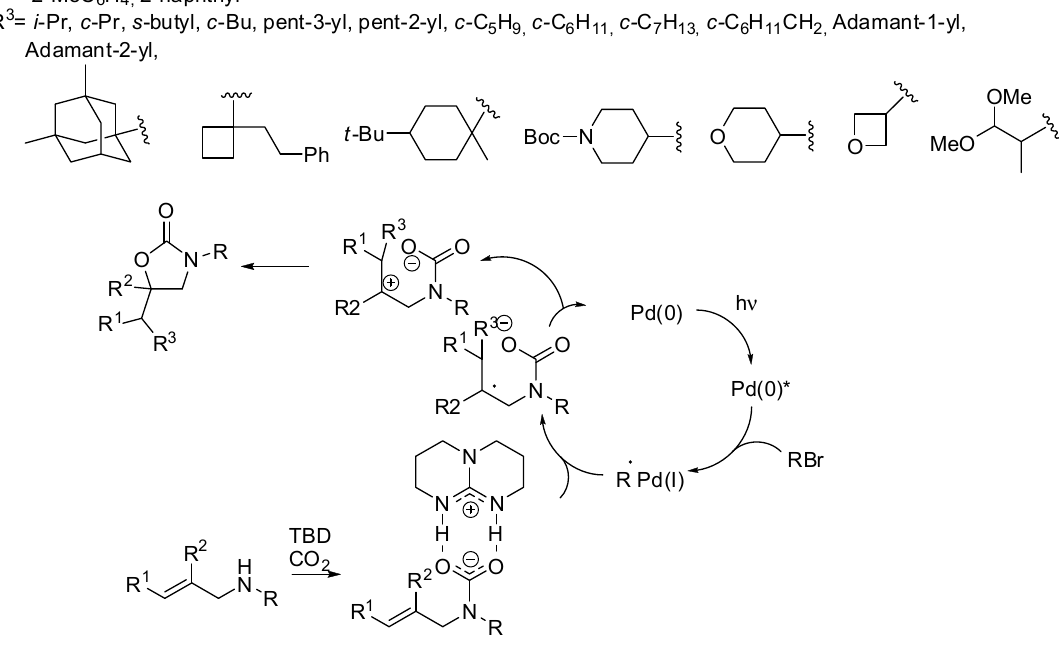
Scheme 18. Visible-light photoredox induced reaction of allylamines with CO 2.